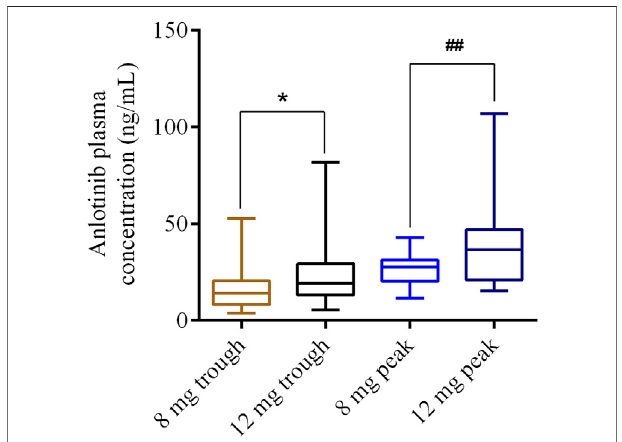
FIGURE 1 | Distribution of anlotinib trough or peak concentrations for 8 and 12 mg dosages, respectively. * p < 0.05; ## p < 0.01.